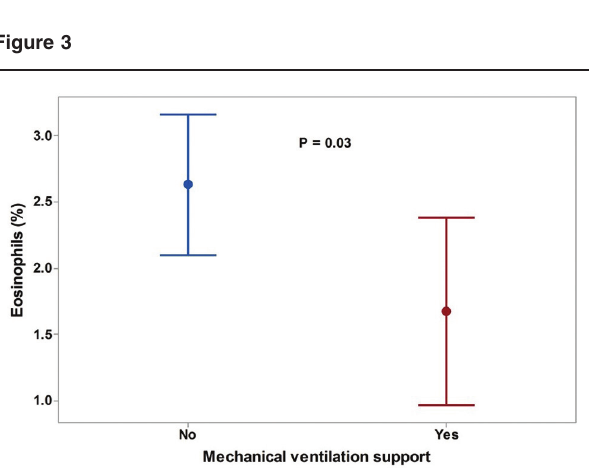
(a) Correlation of CRP with LOS in hospital. (b) Correlation of Eos% level with LOS in ICU. *Correlation coefficient, P < 0.05 considered significant,signs before r denotethe direction ofrelationship.CRP, C- reactive protein; Eos, eosinophils; LOS, length of stay.